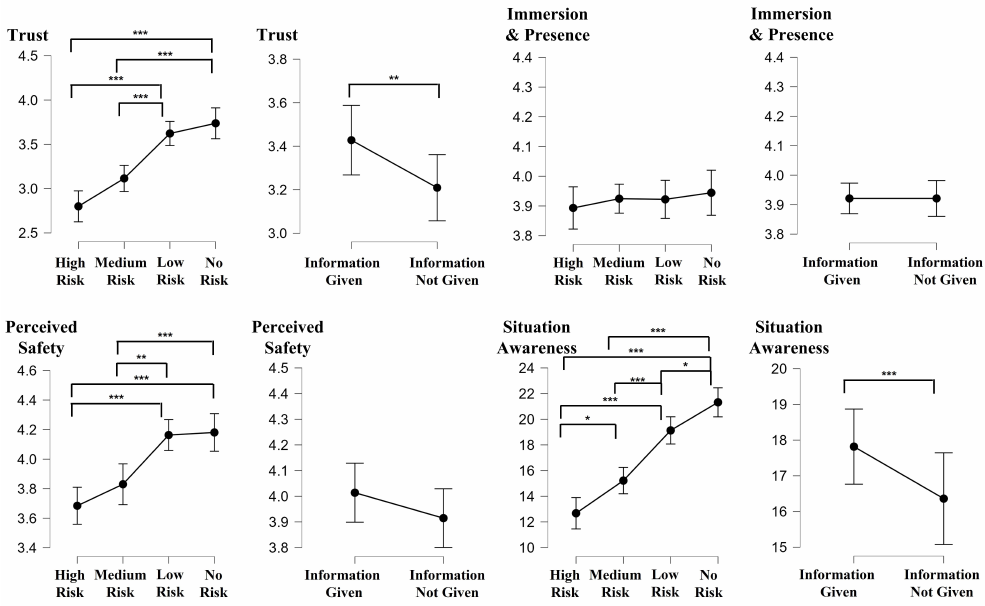
Figure 9. A graph that compares trust, perceived safety, immersion and presence, and situation awareness questionnaire data according to risk level and whether or not information was provisioned through HUD. The use of asterisks in the figure indicates statistical significance. A single asterisk (*) denotes a p -value less than 0.05, while two (**) and three (***) asterisks denote p -values less than 0.01 and 0.001, respectively.